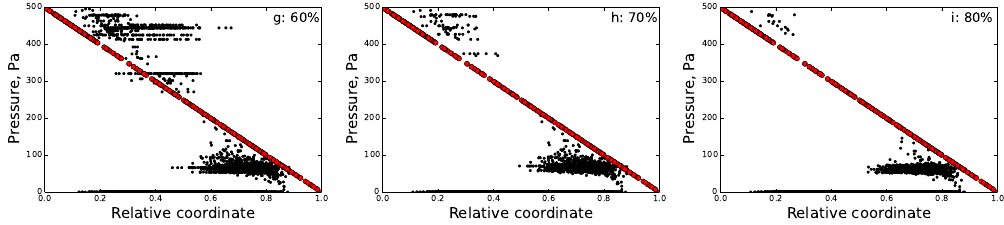
Figure 13. Pressure gradient for ( a – i ) 0%–80% edges removed (gradient boundary conditions). Boundary points are highlighted in